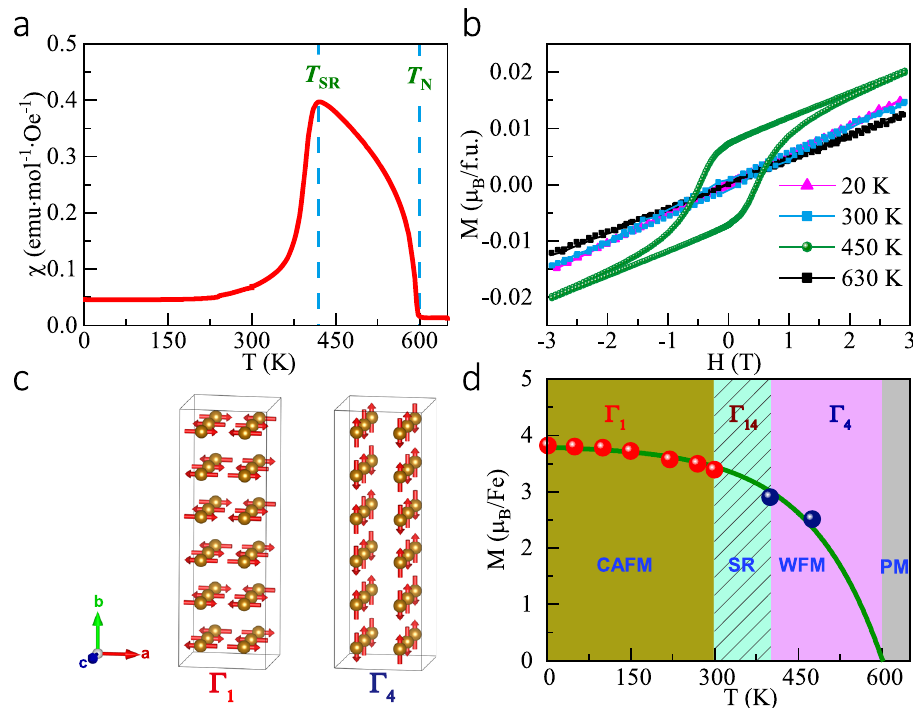
Fig. 5 Magnetism measurements and schematic description of magnetic properties. a Temperature dependence of magnetic susceptibility of PbFeO 3 measured at 0.01 T. b Isothermal magnetization loops measured at various temperatures. c Magnetic structures of PbFeO 3 between T SR and T N ( Γ 4 ) as well as below 300 K ( Γ 1 ). Red arrows depict Fe 3 + moments. d Magnetic-phase diagram for PbFeO 3 . Red and blue spots denote magnetic moments determined from neutron diffraction. The error bars of magnetic moments are within the symbols. Green line provides visual guidance. CAFM collinear antiferromagnetism, WFM weak ferromagnetism, PM